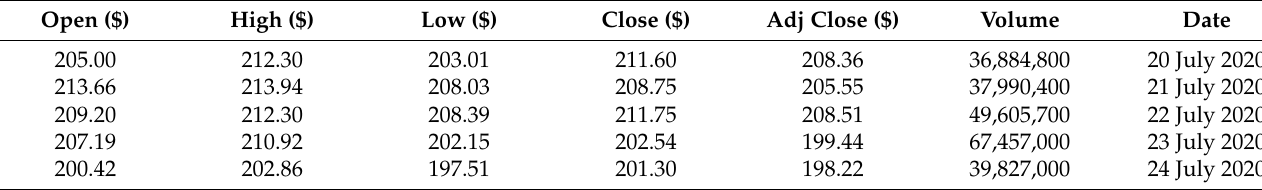
Table 3. Sample of Yahoo! Finance